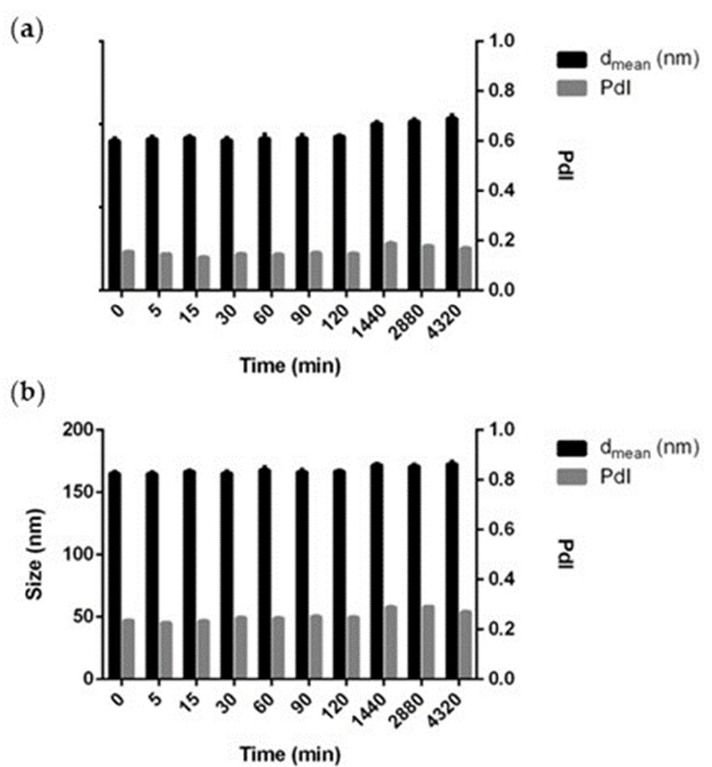
Figure 4. Stability studies of pHResMic ( a ) and TpHResMic ( b ): hydrodynamic diameter and PdI index in PBS pH 7.4 at 37 °C after 72 h. Mean ± SD are reported, n = 3.